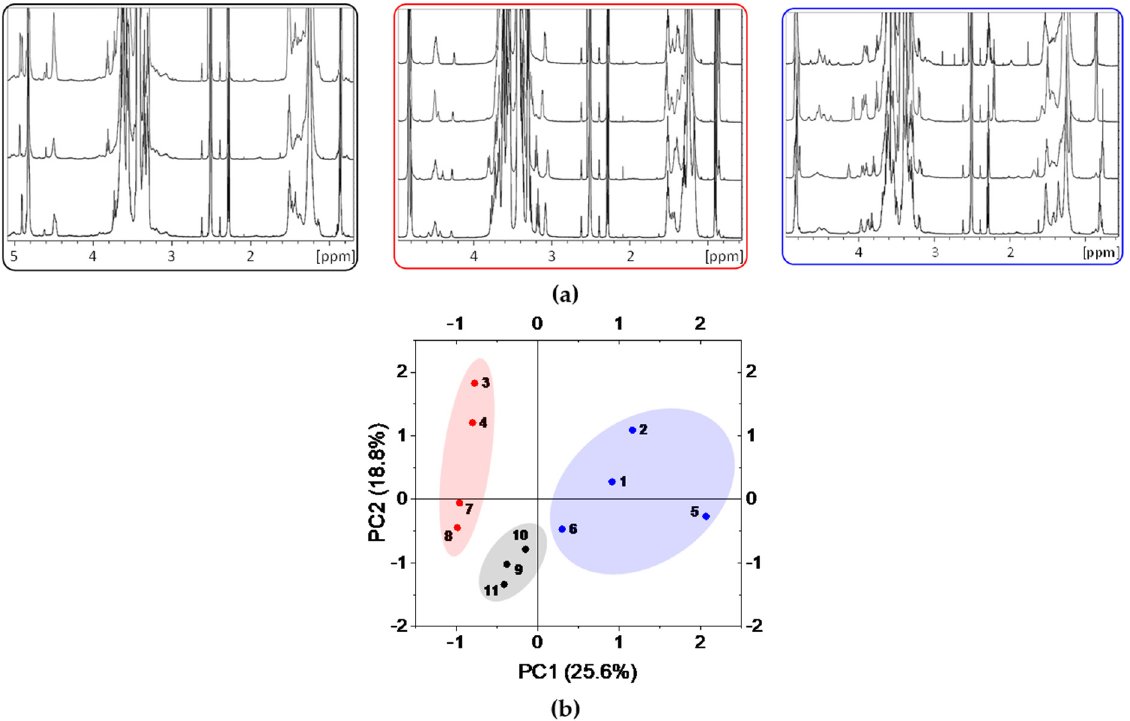
Figure 5. ( a ) 1 H NMR spectra (600 MHz, DMSO/D 2 O 98/2 v / v , 298 K) of the purified isomers: blue group (from bottom to top: 1 , 2 , 5 , 6 ), red group ( 3 , 4 , 7 , 8 ) and black group ( 9 , 10 , 11 − 12 ). ( b ): PCA based on chemical shifts of 1 H spectra.